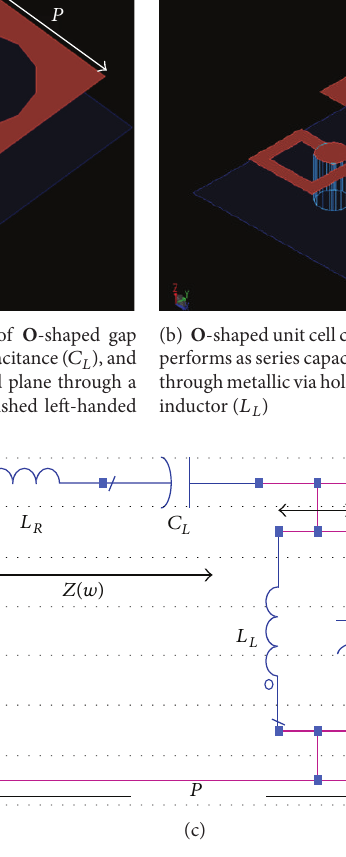
Figure 2: Typical CRLH planar unit cell topology along with its circuit model. The series capacitance 𝐶 𝐿 is implemented as O -shaped gap capacitance and the shunt inductance 𝐿 𝐿 as spiral and rectangular inductors which connected to ground plane through metallic via holes. The substrate FR 4 with height ℎ = 0.8 mm, 𝜀 𝑟 = 4.6 and tan 𝛿 = 1 × 10 −3 has been used in all of the structures of this paper.